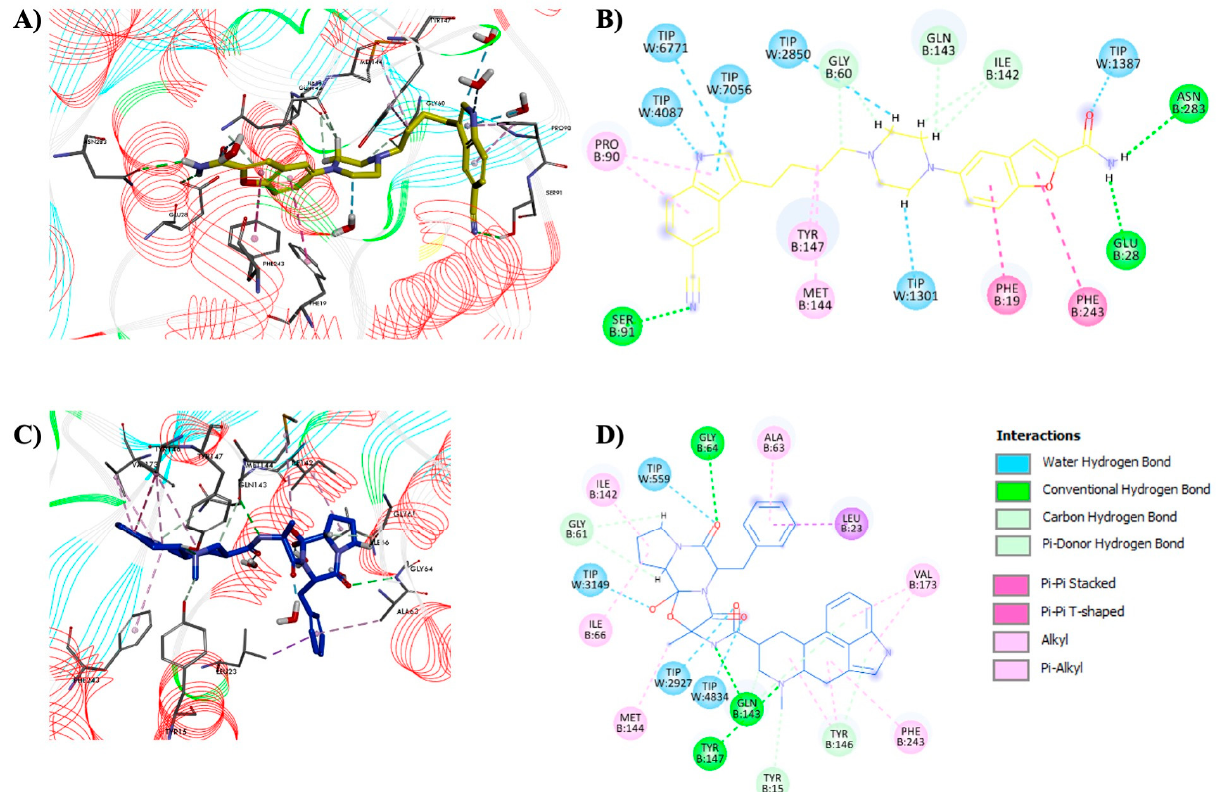
Figure 3. Interactions of the selected compounds with HNMT were obtained by 50 ns of MD simulations. Vilazodone–HNMT complex; binding mode ( A ) and non-bonding interactions ( B ). Dihydroergotamine–HNMT complex; binding mode ( C ) and non-bonding interactions ( D